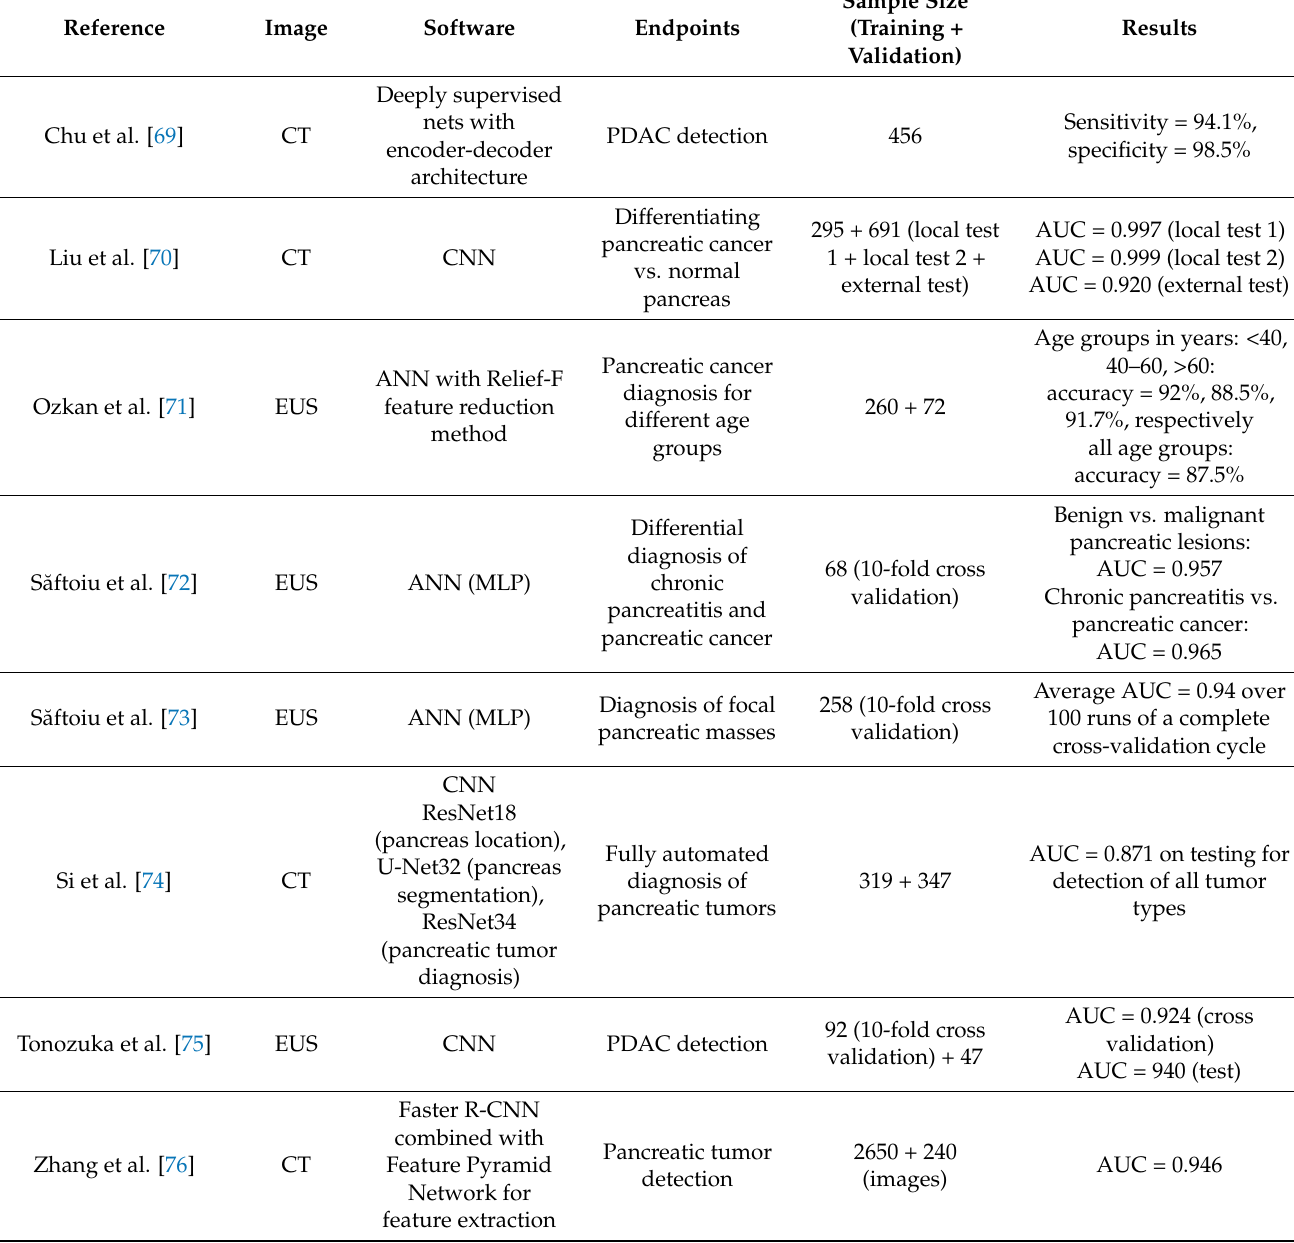
Table 4. Deep learning studies in pancreatic cancer detection and diagnosis.